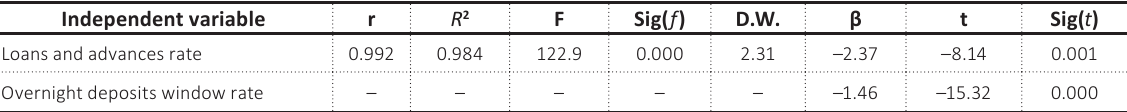
Table 4. Multiple linear regression for testing the effect of actions of the Central Bank of Jordan